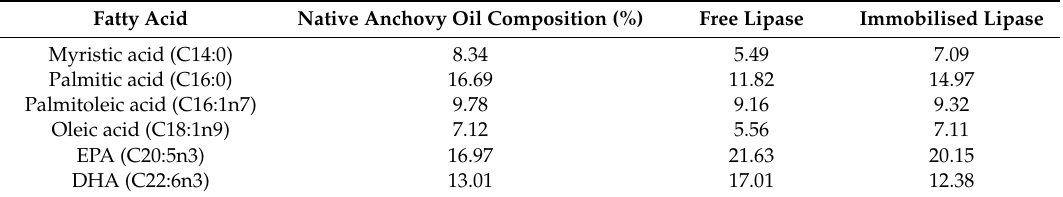
Table 3. Fish oil hydrolysis by immobilised and free lipase. All experiments in this study were carried out in duplicate with standard deviation below 5%. EPA: eicosapentaenoic acid; DHA: docosahexaenoic